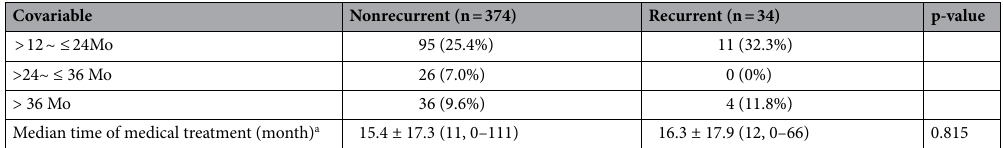
Table 3. Analysis of possible risk factors for recurrent ovarian endometrioma (n = 408). BMI, body mass index;CA125, cancer antigen 125; AMH, anti-Mullerian hormone; rASRM, revised American Society for